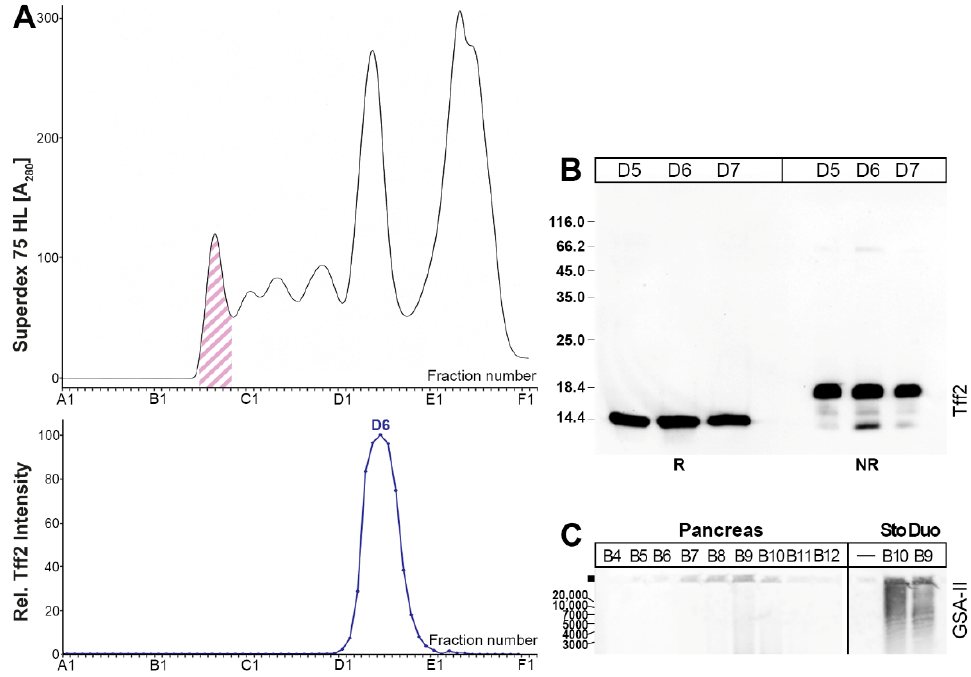
Figure 3. Analysis of a murine pancreatic extract (3 animals). ( A ) Elution profile after SEC on a Superdex 75 HL column as determined by absorbance at 280 nm (faint PAS-positive mucin fractions: pink-hashed). Underneath: Distribution of the relative Tff2 content as determined by Western blot analysis under reducing conditions and semi-quantitative analysis of the monomeric band intensities. ( B ) 15% SDS-PAGE under reducing (R) and non-reducing (NR) conditions, respectively, and Western blot analysis of the low-molecular-mass fractions D5–D7 concerning Tff2. ( C ) 1% AgGE and Western blot analysis of high-molecular-mass fractions B4–B12 concerning Muc6 (lectin GSA-II). As positive controls, equivalent samples from the stomach (Sto) and duodenum (Duo), respectively, were analyzed. Relative standard: DNA ladder (base